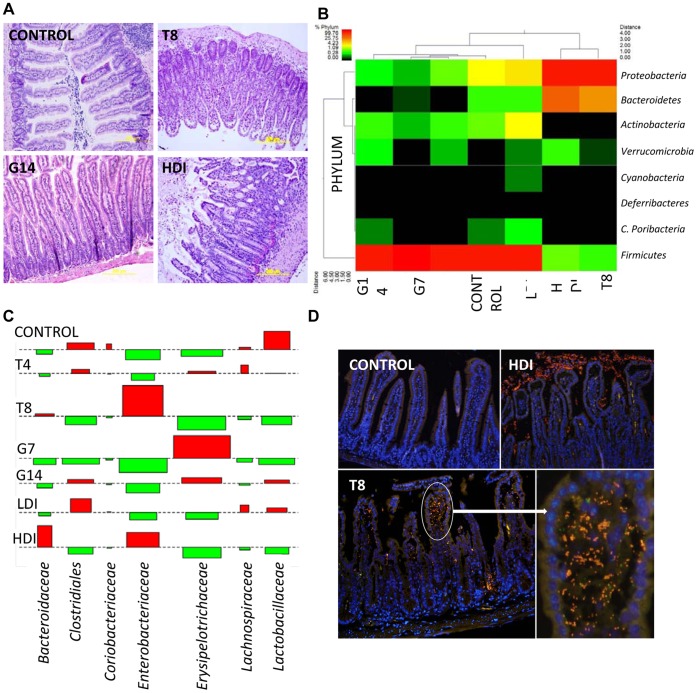

T. gondii infection and high dose indomethacin trigger severe ileitis, dysbiosis and mucosal E. coli invasion in C57BL/6 mice.(a) Histopathology. Normal ileal histology (inflammation score median  = 0, range 0–0) in control mice. Moderate to severe ileitis (4, 3–6) develops in T. gondii mice at 8 days post-infection (T8). G. muris-infected mice develop minimal inflammation (1, 1–1) and mucosal hyperplasia 14 days (G14). High dose indomethacin (HDI) induces severe ileitis (5, 5–7) (H&E 40x). (b) Pyrosequencing reveals a Gram− shift associated with ileitis. Gram+ bacteria predominate in control mice and mice with mild inflammation (G7, G14: Giardia 7 and 14 days p.i., T4: T. gondii 4 days p.i.; LDI: low-dose indomethacin). A shift to >95% Gram− bacteria dominated by the phyla Proteobacteria and Bacteroidetes (p<0.0001) is associated with moderate to severe ileitis in T8 and HDI mice. (c) Association plots of the number of sequences obtained by pyrosequencing corresponding to bacterial families. The area of each rectangle is proportional to the difference in observed and expected frequencies on chi square analysis. The observed frequency of a rectangle is indicated by position relative to baseline, increased (shaded red) or decreased (shaded green) highlighting the ileitis-associated shifts from Firmicutes (Lactobacillaceae, Clostridiales) to Enterobacteriaceae (T8, HDI) and Erysipelotrichaceae (G7, G14, T4). (d) Eubacterial FISH reveals scant luminal and mucosa-associated flora in control mice (EUB338-Cy3, non-EUB338-6FAM with DAPI counterstaining, 40x). Ileitis in T8 and HDI is associated with increased mucosal bacteria and invasive E. coli (E. coli-Cy3, EUB338-6FAM, 40x).